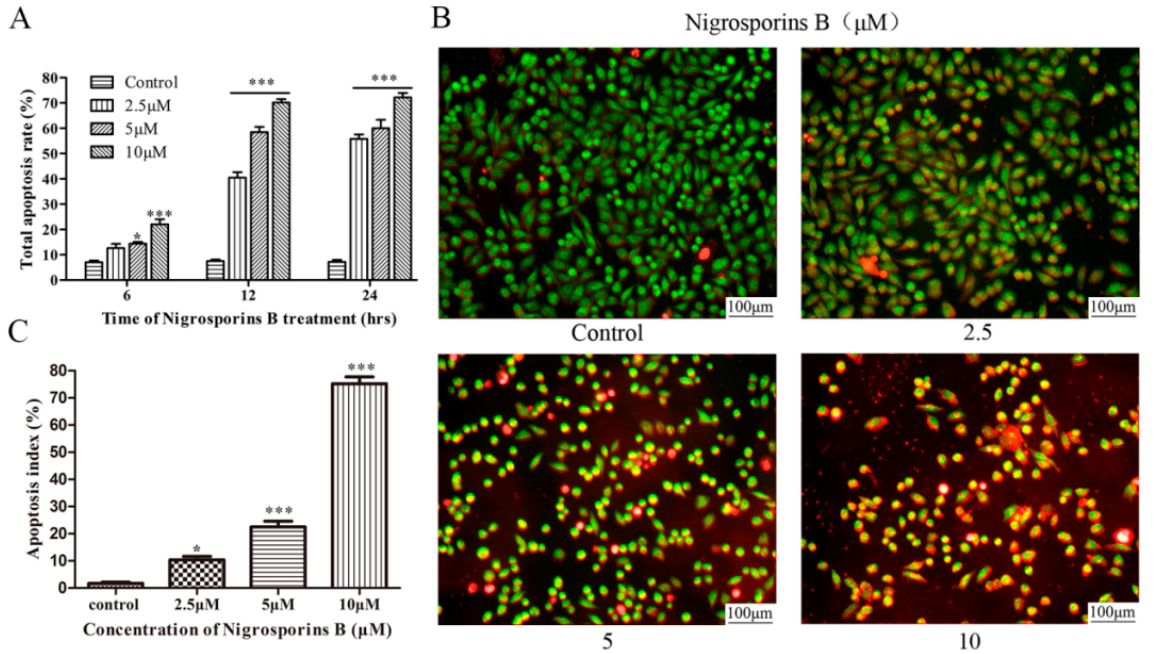
Figure 3. Nigrosporins B induced apoptosis in Ca Ski cells. ( A ) The total apoptotic cells proportion treated with Nigrosporins B (0, 2.5, 5, 10 µM) for 6 h, 12 h, 24 h were counted respectively; ( B ) and ( C ) AO/EB dual fluorescence staining to detect apoptosis in Ca Ski cells, cells treated with Ni- grosporins B (0, 2.5, 5, 10 µM) for 24 h. Scale bar: 100 µM. Normal cells, showed green showed green fluorescence; early-stage apoptotic cells showed yellow-green fluorescence; late-stage apoptotic cells showed orange fluorescence; necrotic cells showed red fluorescence (* p < 0.05, *** p <